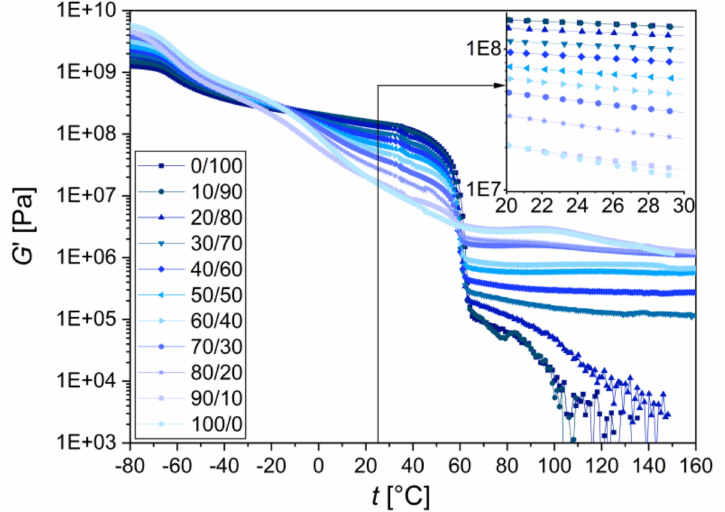
Figure 7. Results of DMTA: storage modulus ( G (cid:48) ) is a function of temperature ( T ) for all TPS/PCL blends. The inset shows detail of the region around room